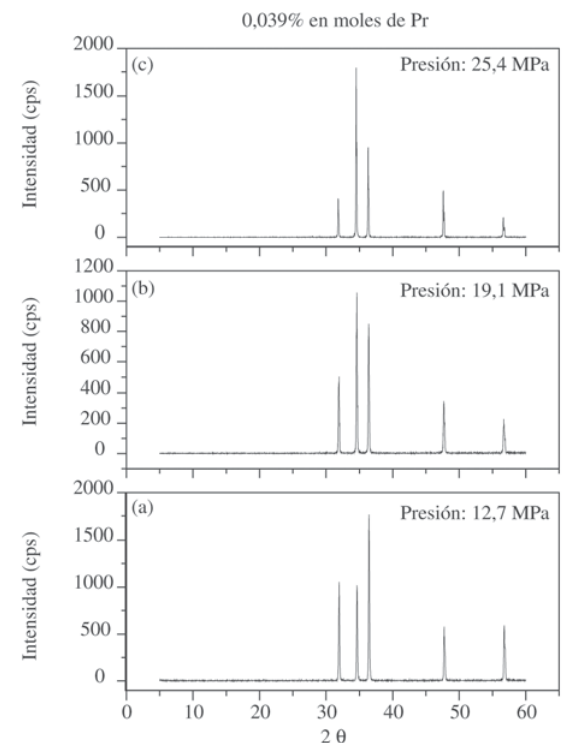
Figura 5. Difractogramas de rayos-X de muestras que contienen 0,039% en moles de Pr sometidas a diferentes presiones durante el conformado y sinterizadas a 1200 °C durante 2